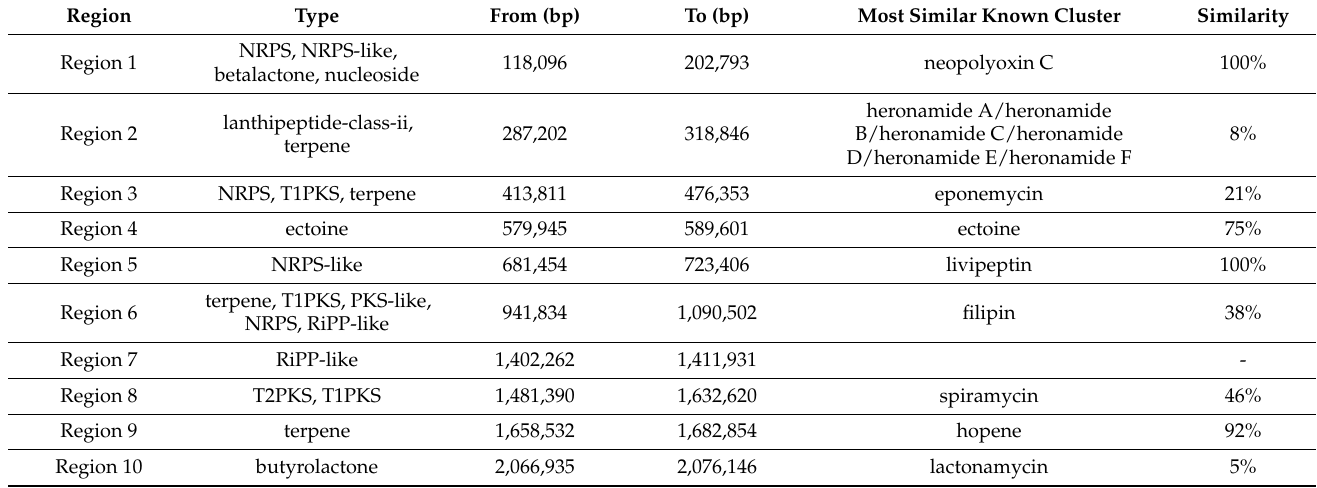
Table 1. AntiSMASH analysis of genome sequence of the S. ansochromogenes